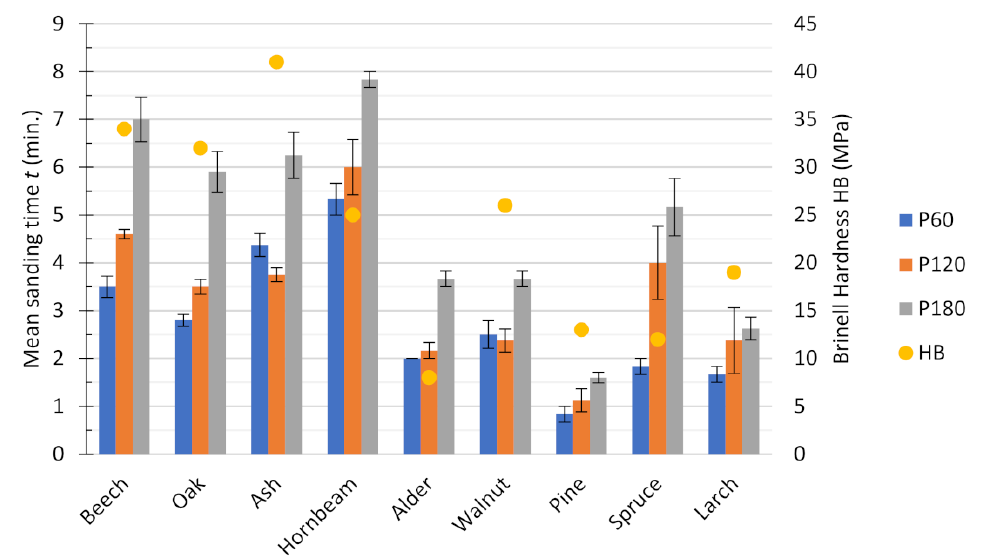
Figure 12. Average sanding time for sample sets sanded with different grit